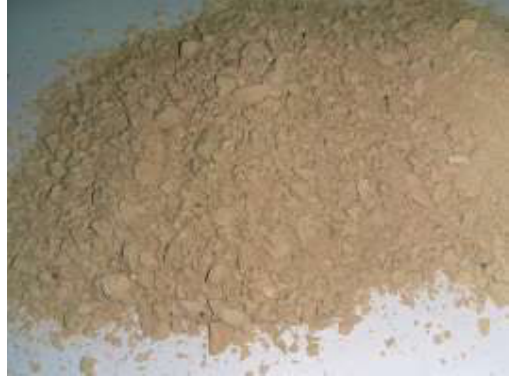
Figure 4. Waste white ceramics mixed with Portland clinker before grinding.